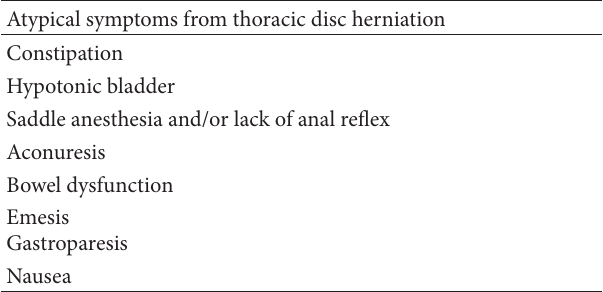
Figure 2: A thoracic spine T2-weighted axial (a) and sagittal (b). MRI showed a central disc herniation at the T10-11 level with compression of the spinal cord with myelomalacia changes at that level. The herniated disc appeared to be soft with no calcified component.